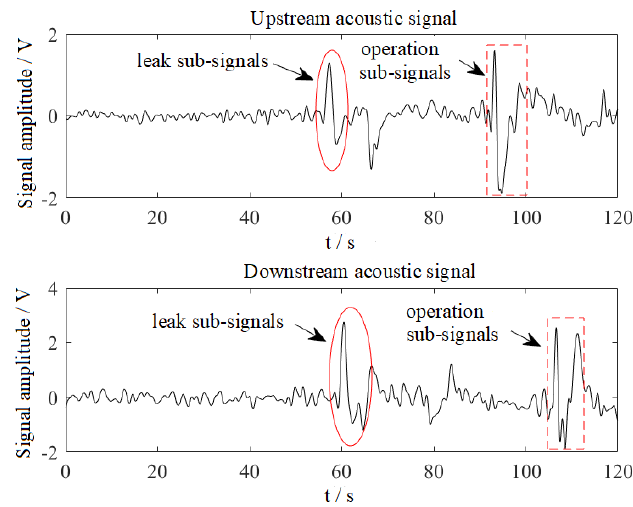
Figure 11. Abnormal signal example with leak and operation sub-signals.